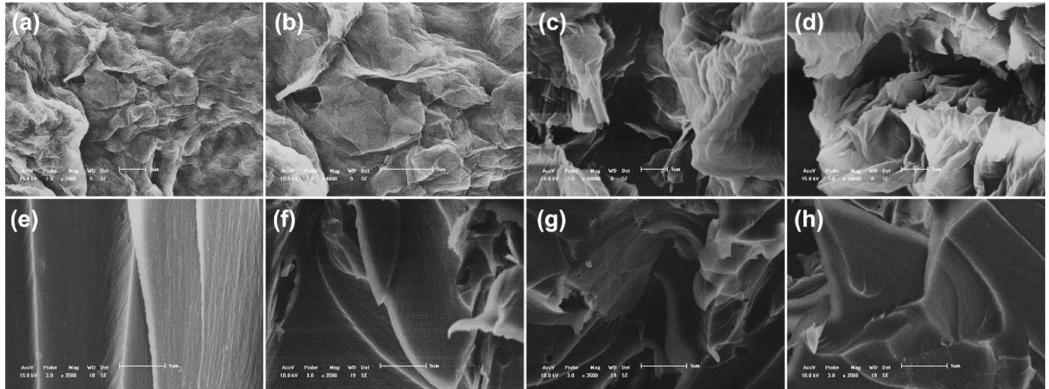
Figure 4. Typical scanning electron microscopy (SEM) images of ( a , b ) GO and ( c , d ) MGO; and the fracture surface SEM images of ( e ) WEGC-G0 (WEGC with no addition of GO), ( f ) WEGC-G1(WEGC with 0.1 wt.% GO), ( g ) WEGC-G5(WEGC with 0.5 wt.% GO), and ( h ) WEGC-G10(WEGC with 1.0 wt.% GO).